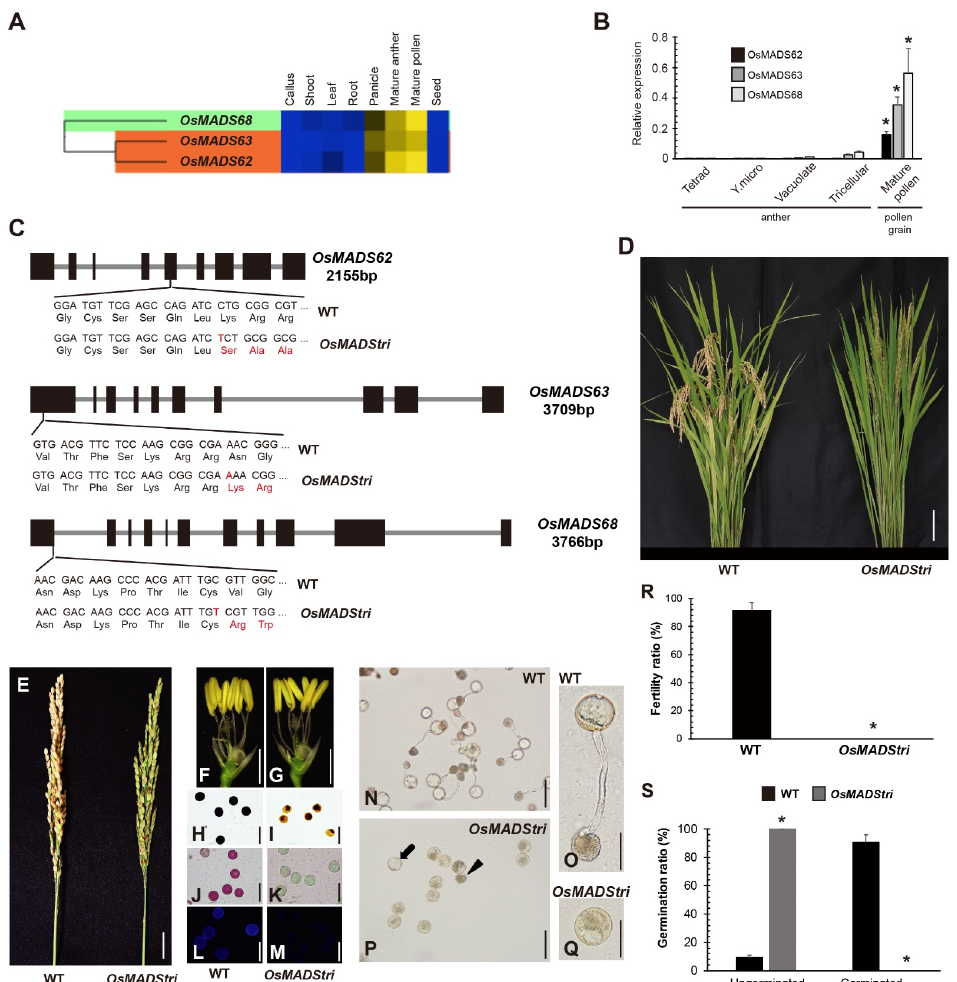
Figure 1. The mutation target site and phenotype of OsMADStri . ( A ) Gene expression pattern of three OsMADS using CAFRI-rice. Leaf, 7 days before flowering to 7 days after flowering; Shoot and Root, 7 days after germination; Panicle, 7 days before flowering; Mature anther, anther at anthesis period. Heatmap displays the expression value according to the color gradation. Blue is the lowest, and yellow is the highest expression value. ( B ) The transcriptome expression pattern of the three OsMADS genes in anther at various developmental stages and pollen grains after anther dehiscence. Tetrad, the anther that contains mitotic pollens at late tetrad stage; Y. micro, the anther that contains pollens at young microspore stage; Vacuolate, the anther that contains pollens at vacuolated microspore stages; Tricellular, mature anther with trinucleate pollen; Mature pollen, the pollen grains right after anther dehiscence. Error bars indicate the standard deviation and p -value calculated by one-way Analysis of Variance (ANOVA). *, p < 0.01. ( C ) OsMADS62 , OsMADS63 , and OsMADS68 , the target genes of OsMADStri . The gene size is written below its name by base pairs. The fifth exon of OsMADS62 was a target site, and thymine was inserted. The first exon of OsMADS63 and OsMADS68 were mutated by one base insertion, respectively. bp, base-pair; WT, wild-type. ( D ) The phenotype of the whole plant. Bars = 10 cm. ( E ) The panicle pictures of WT and OsMADStri . Bars = 2 cm. ( F , G ) The pictures of reproductive tissue of WT and OsMADStri . Bars = 2 mm. ( H – M ) Histochemical staining of the mature pollen grain of WT and OsMADStri . ( H , I ) is the iodine potassium iodide staining, ( J , K ) is Ruthenium red staining, ( L , M ) is Calcofluor white staining. Bars = 80 µ m. ( N – Q ) In vitro germination is performed in solid pollen germination media. Black arrow and triangle indicate hydrated and unhydrated pollen grains, respectively. Bars = 80 µ m, 40 µ m. ( R , S ) Fertility ratio and germination ratio of WT and OsMADStri . Error bars indicate the standard deviation and p -value calculated by one-way Analysis of Variance (ANOVA). *, p <